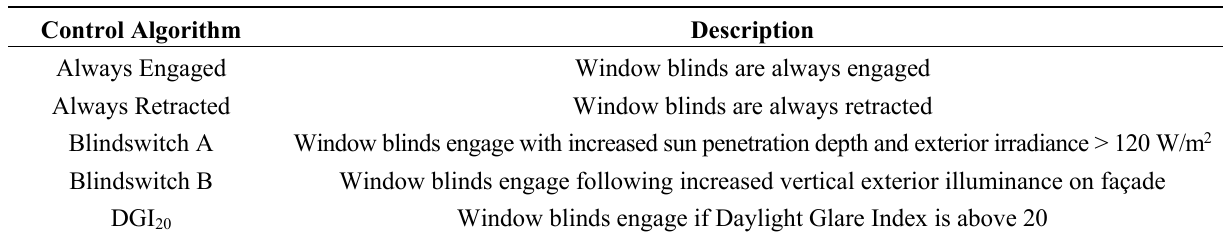
Table 1. Blind control